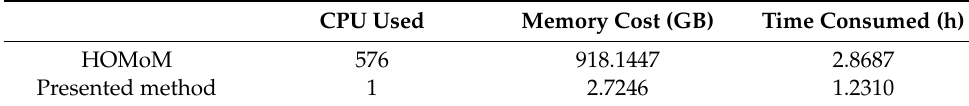
Table 1. Comparison of computing cost.